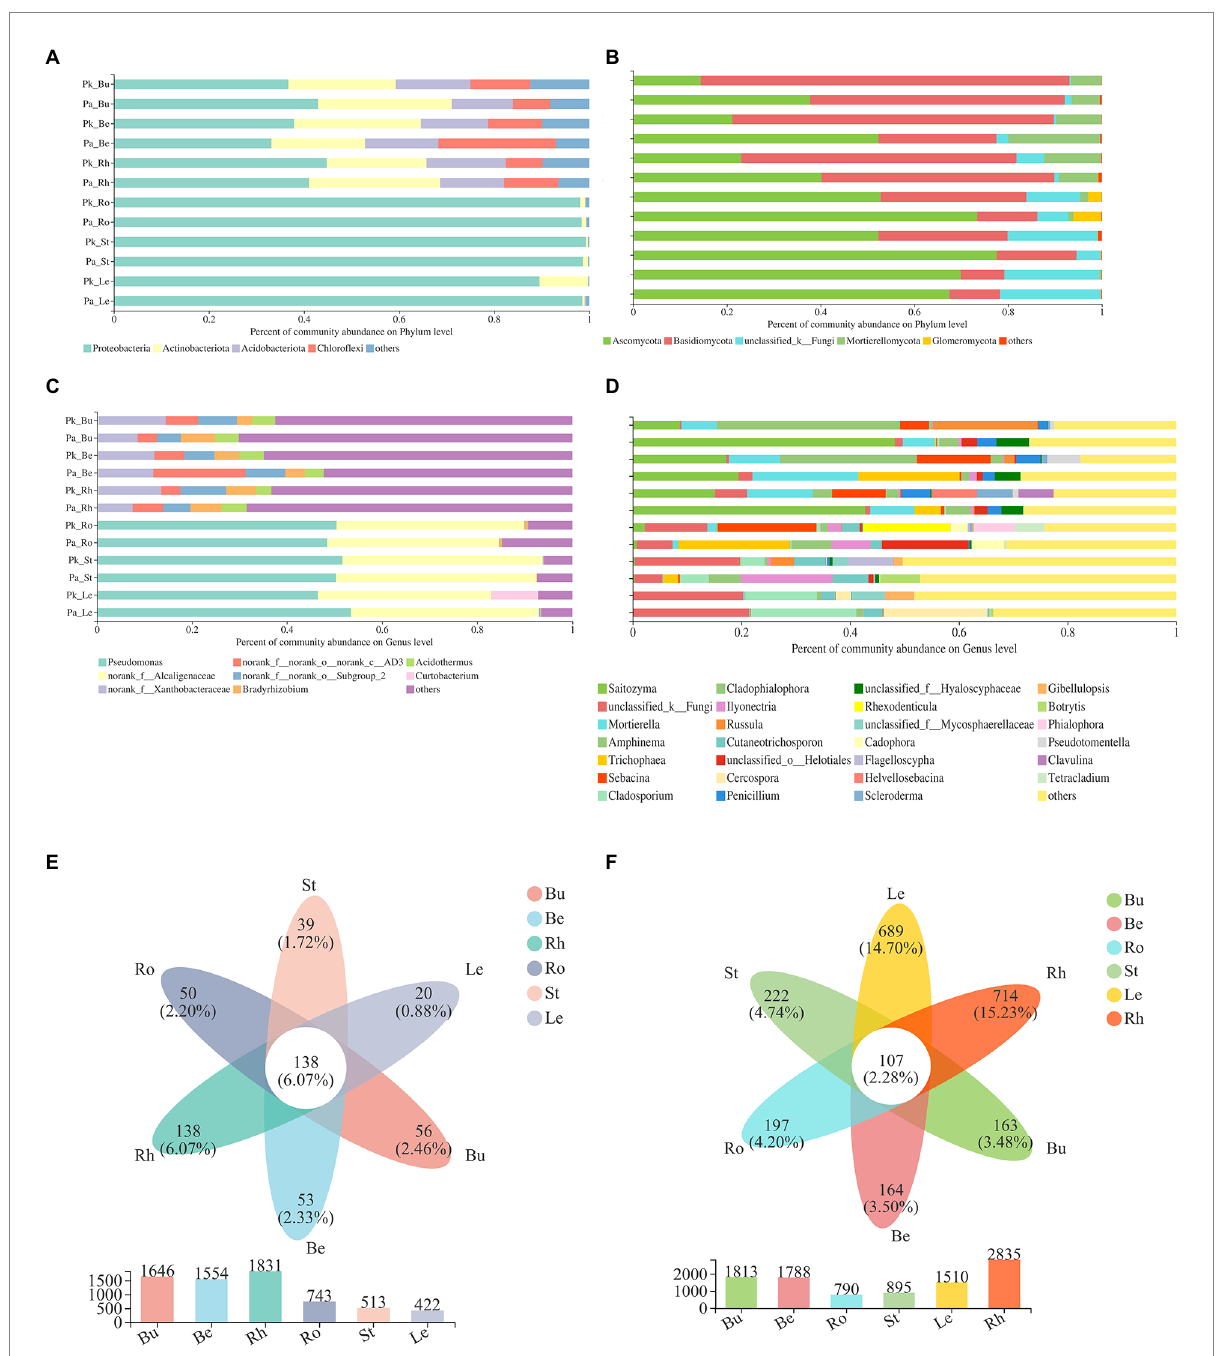
FIGURE 6 The relative abundance of the most abundant bacterial (A,C) and fungal (B,D) communities of P.n. at the phylum and genus level (means, n = 3), Venn diagram showing the number of shared and unique bacterial (E) and fungal (F) communities at the OTU